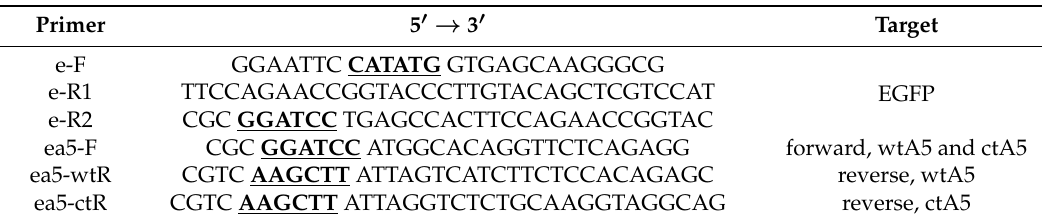
Table 3. Primers for EGFP fusion